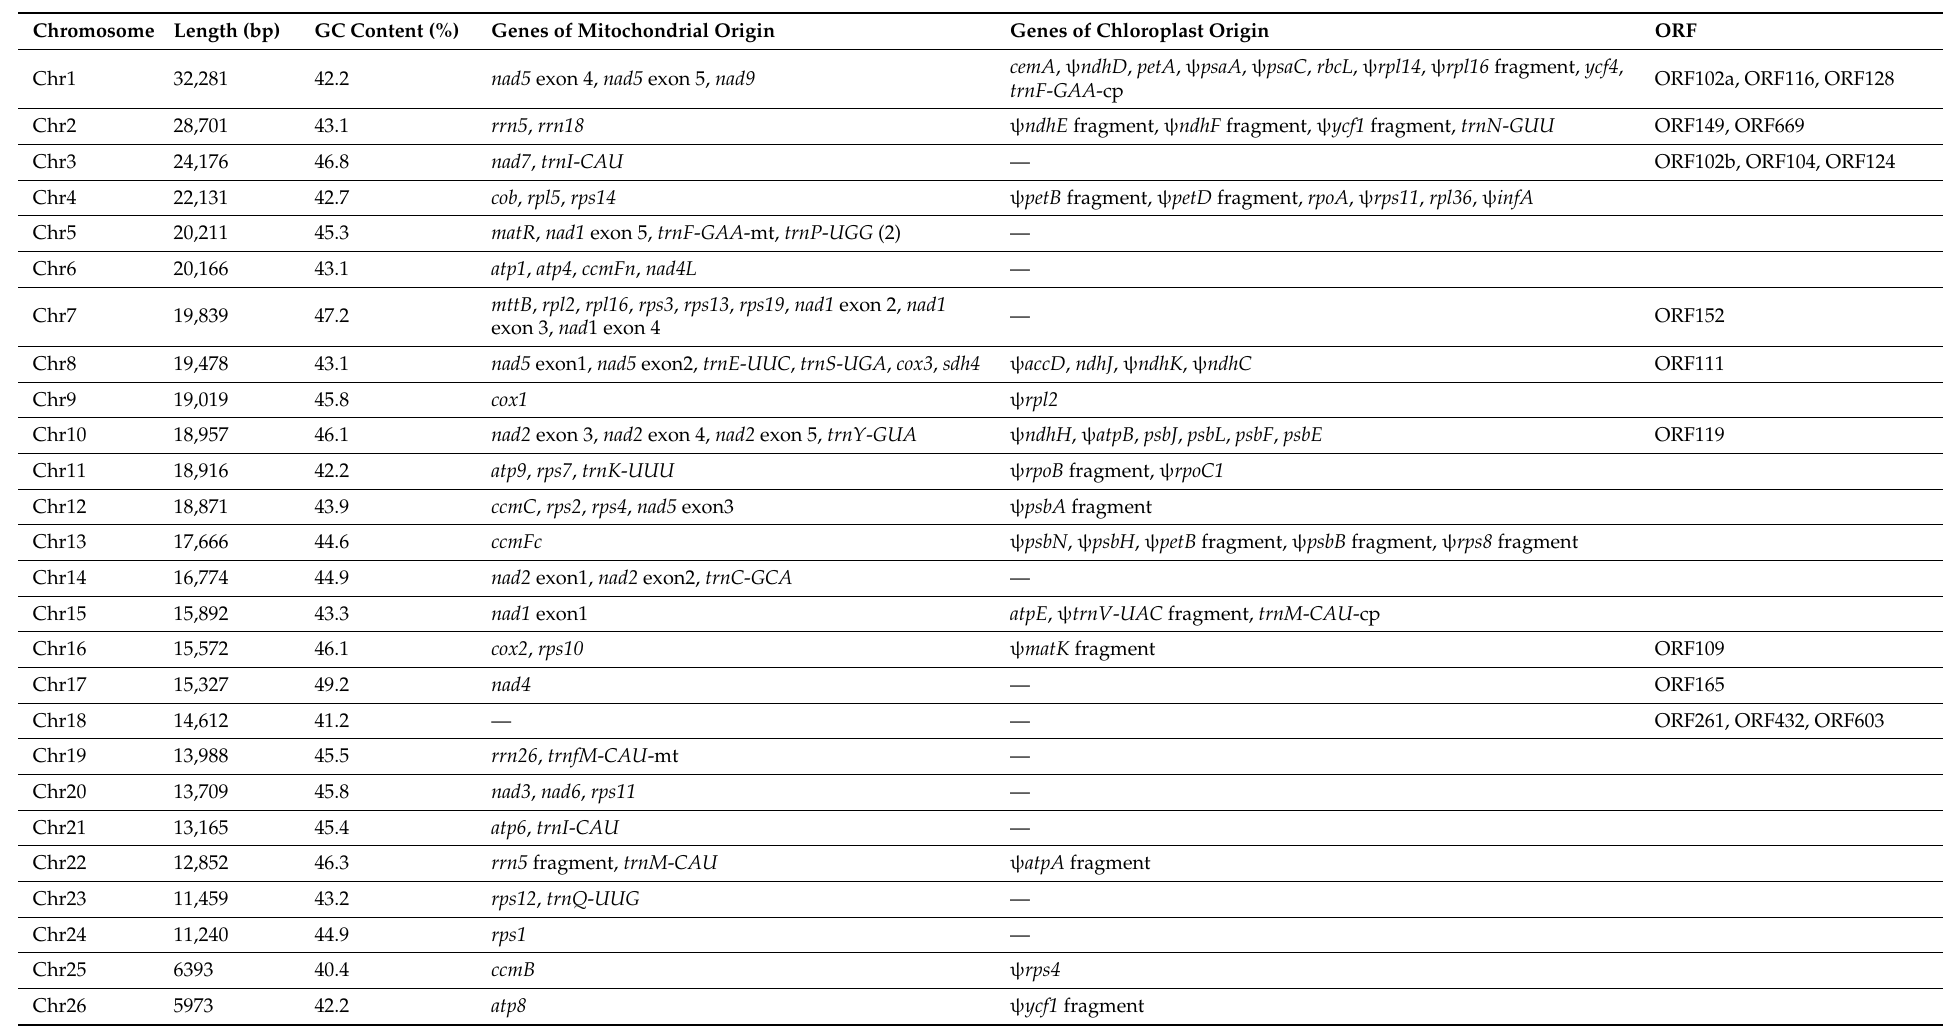
Table 2. Gene content of the mitogenome of Paphiopedilum micranthum